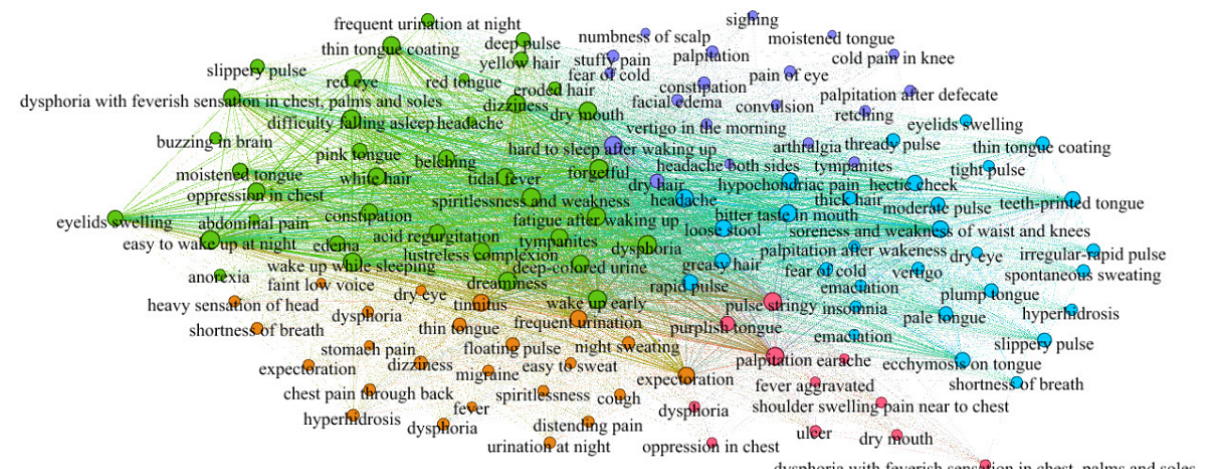
Figure 11. Symptom communities (d=128 and c=5).